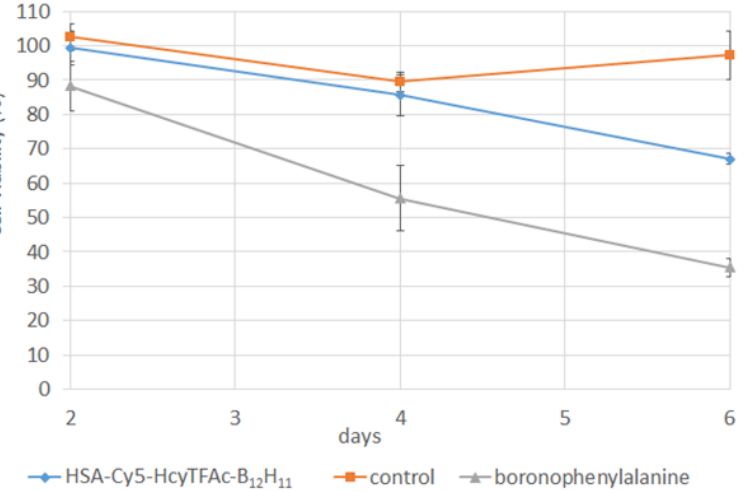
Figure 8. The cell viability of U87MG cells incubated with HSA-Cy5-HcyTFAc-B 12 H 11 conjugate and BPA before BNCT at 2, 4, and 6 days after neutron irradiation. Control: U87MG cells after neutron irradiation without boron-containing compounds.